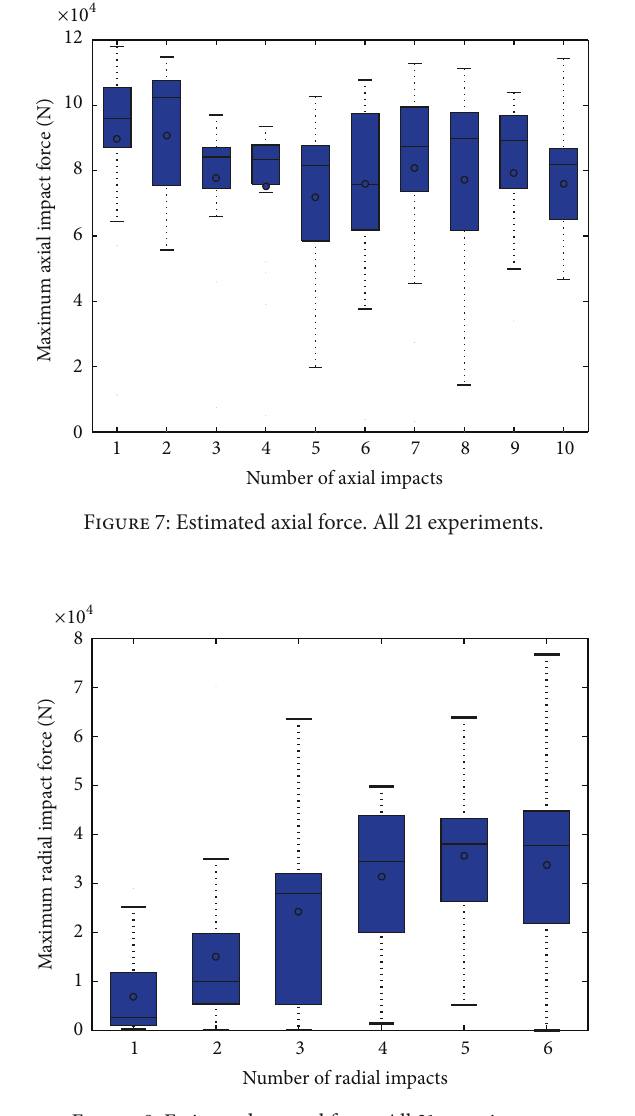
Figure 8: Estimated normal force. All 21